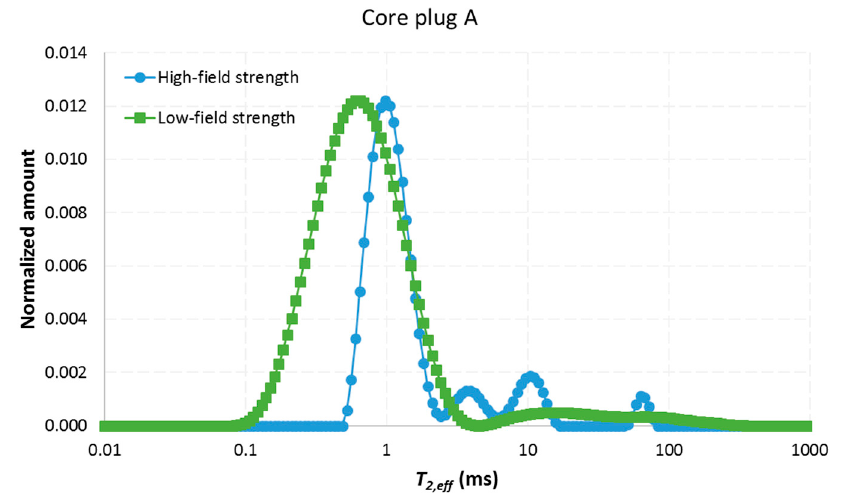
Figure 8. Transverse relaxation distribution for core plug A obtained by the CPMG sequence at high-field strength, B 0 = 4.70 T, and low-field strength, B 0 = 0.28 T. The low-field distribution is normalized with respect to the bulk water distribution, and the sum of the data points is a measure of the porosity of the core plug. The high-field distribution is scaled to the amplitude of the low-field distribution.